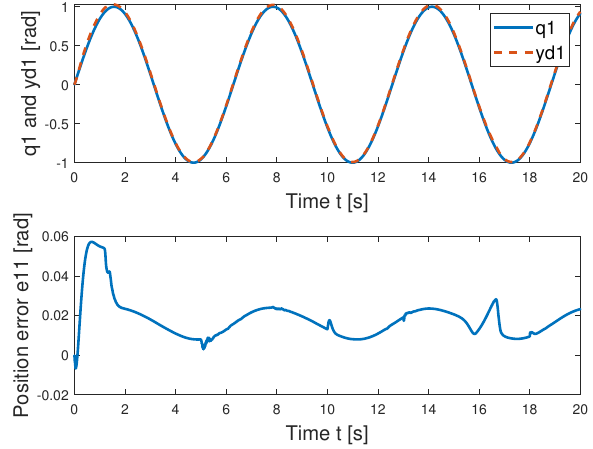
Figure 3. q 1 position trajectory and tracking error e 11 (MB control).